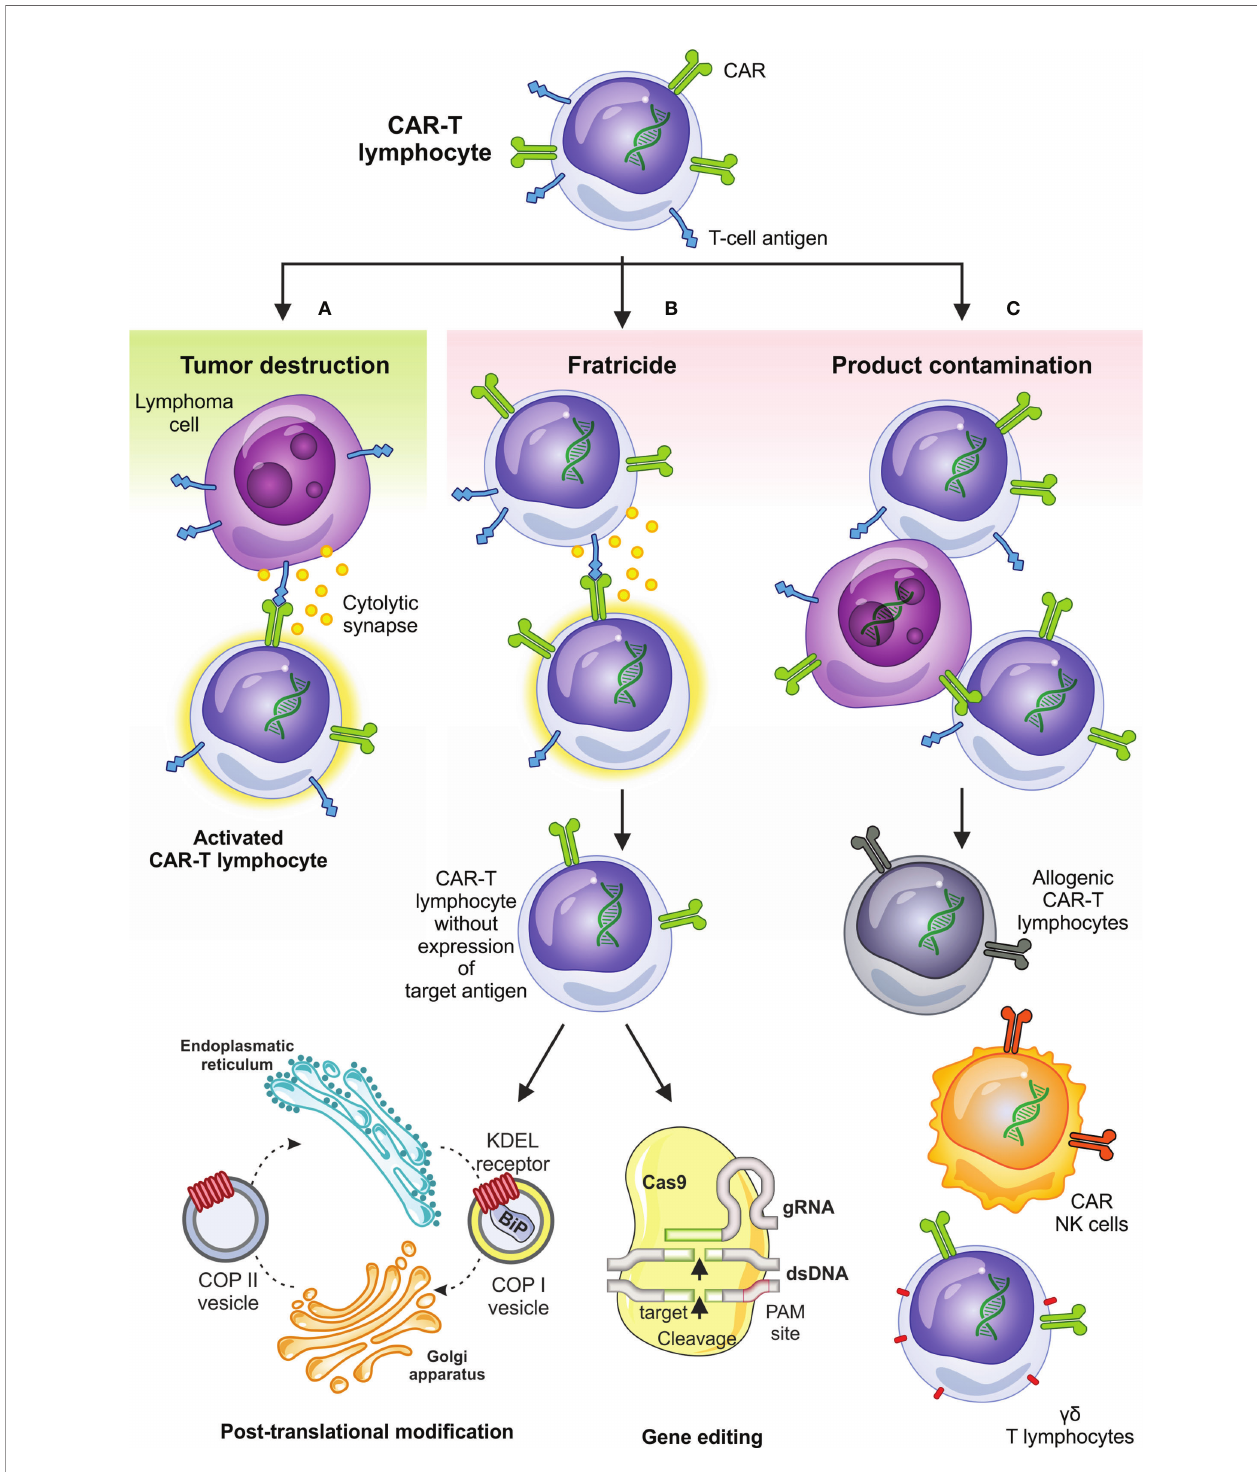
FIGURE 1 | Desired and undesired effects of CAR-based therapy in T-cell malignancies and selected circumventing approaches. Besides on-target antitumor activity (A) the anti-T-NHL CAR-T cell therapy can be complicated by fratricide – on target killing of CAR-T cells expressing T-cell antigens (B) , which can be overcome by limiting super fi cial T-cell antigen expression using genetic as well as posttranslational modi fi cations; contamination of the fi nal product by transduced tumor cells (C) is another undesired effect observed in anti-T-NHL CAR-T setting and can be overcome by the use of allogeneic CAR-T cells, transduction of NK-cells or by selection and use of ƴ d T lymphocytes. BiP, immunoglobulin heavy chain binding protein; COPI, coated protein I; COPII, coated protein II; ds-DNA, double-stranded DNA; gRNA, guiding RNA; KDEL receptor, K = lysine, D = aspartic acid, E = glutamic acid, L = leucin; PAM, protospacer adjacent